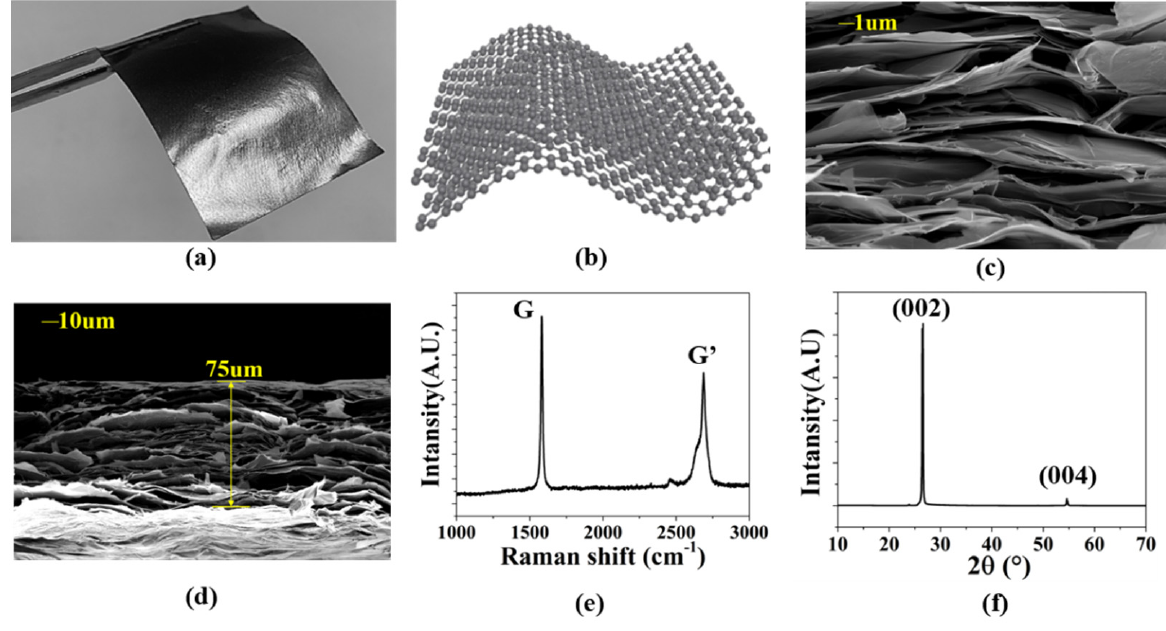
Figure 1. ( a ) The photograph of the CGF. ( b ) Molecular structure of CGF. ( c ) The SEM image of CGF. ( d ) The thickness of CGF. ( e ) Raman spectra of CGF. ( f ) XRD pattern of CGF.